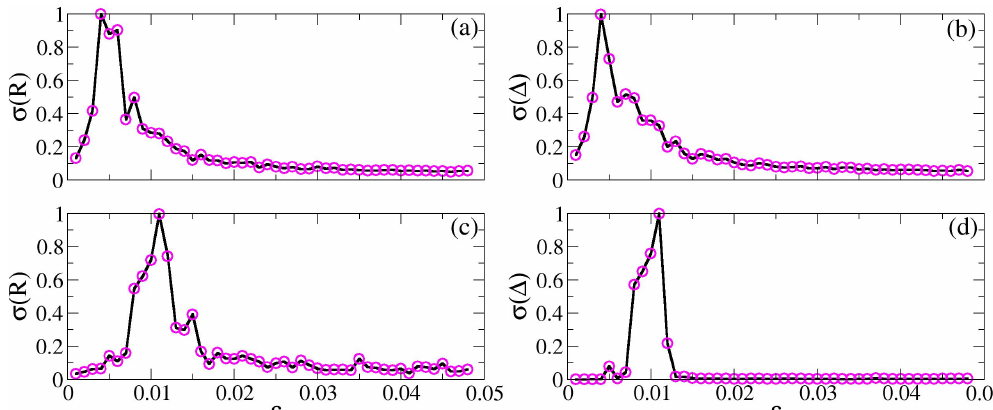
Figure 7. Normalized temporal standard deviation ( σ ), described by Equation (12), as a function of coupling strength for the scale-free network (panels ( a ) and ( b )) and the small-world network (panels ( c ) and ( d )). Here the time series of the Kuramoto order parameter (panels ( a ) and ( c )) and the determinism time series (panels ( b ) and ( d )) are considered. A higher value of σ indicates an intermittent behavior. The local maximum is observed in the transition region, indicating non-stationary